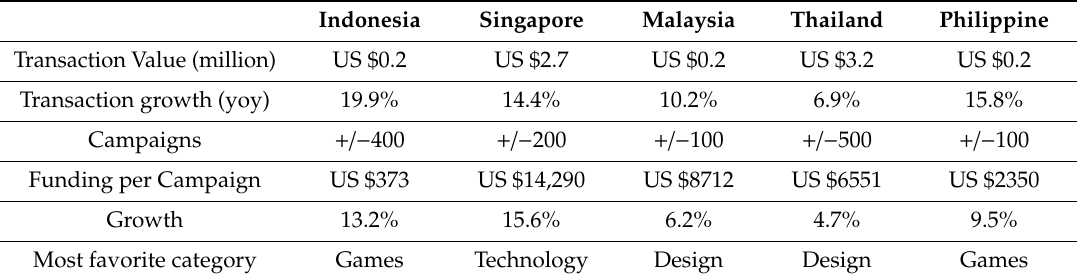
Table 7. Comparison of performance in ASEAN crowdfunding (January–February